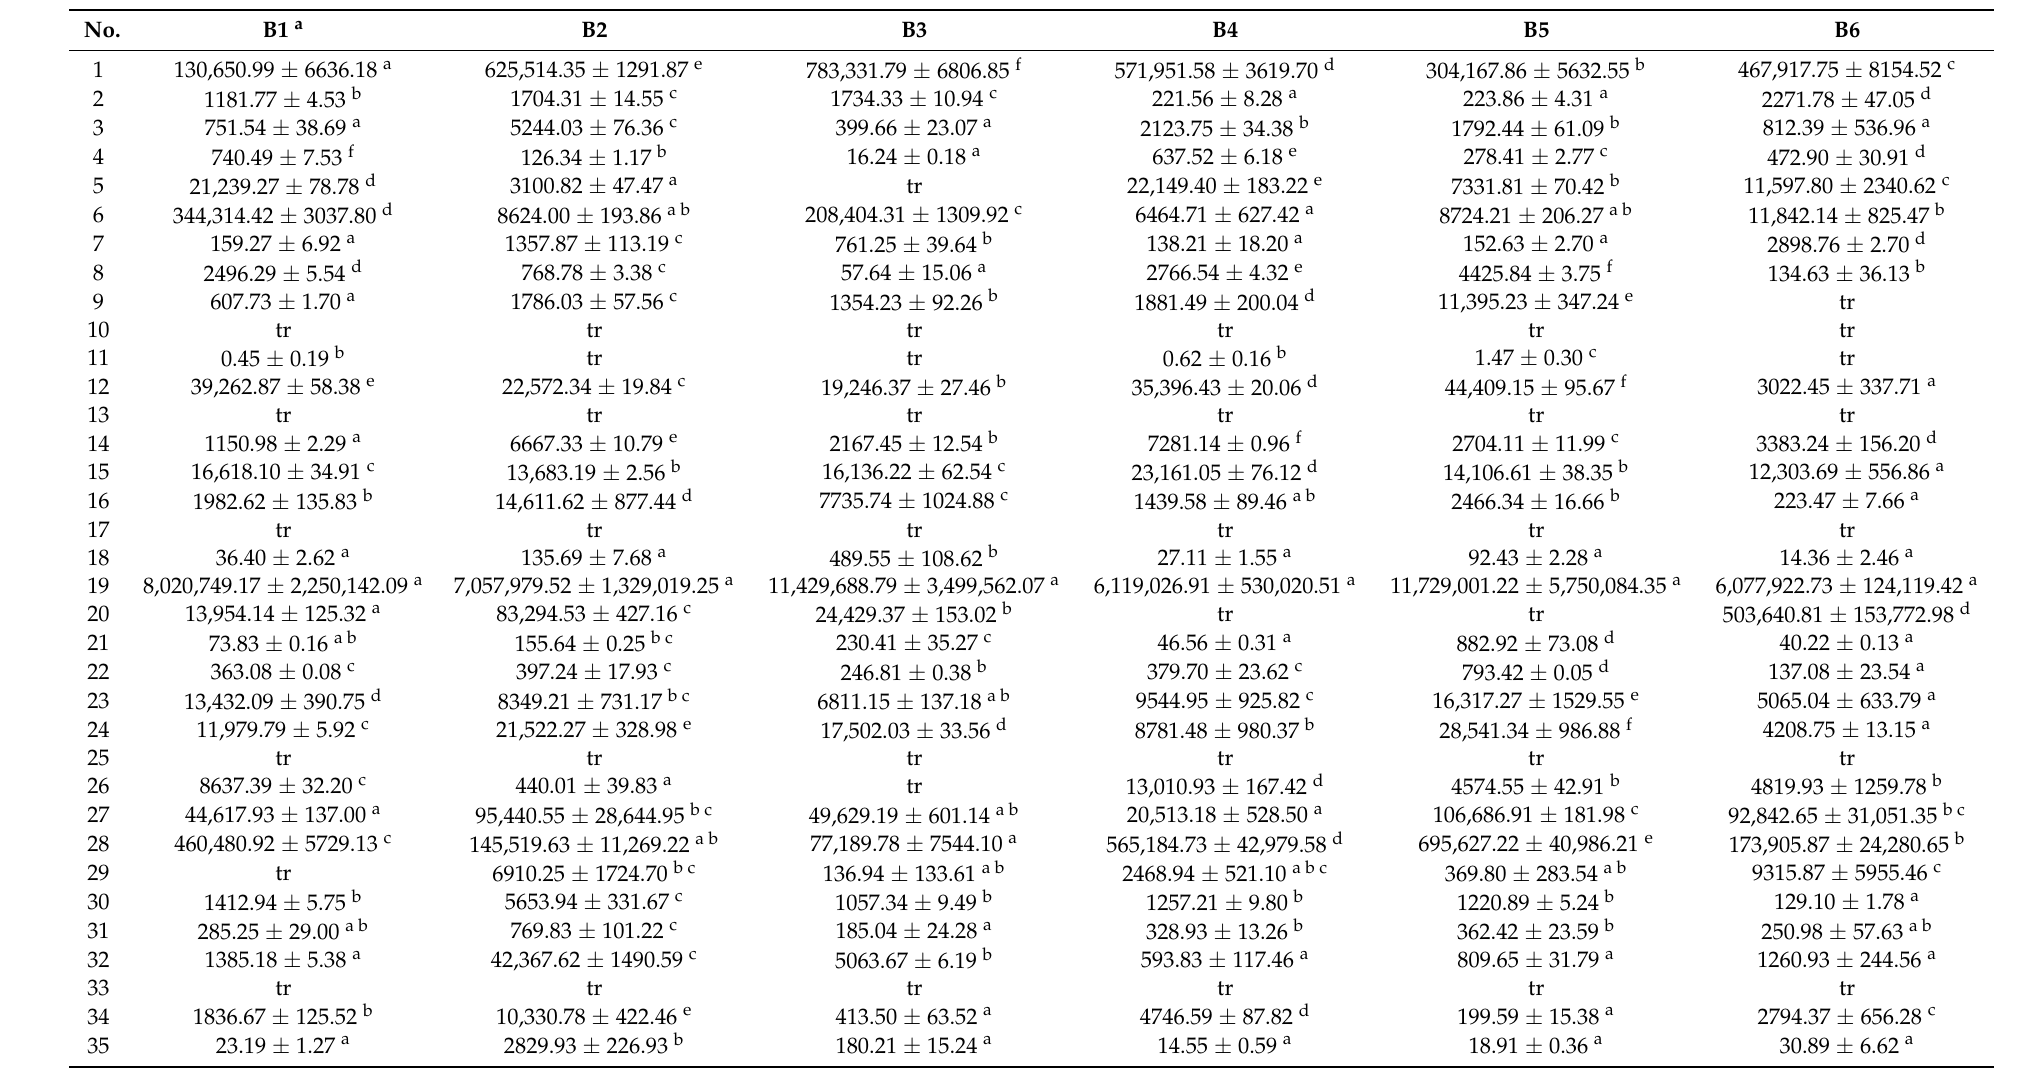
Table 4. Content information of vinegar compounds ( µ